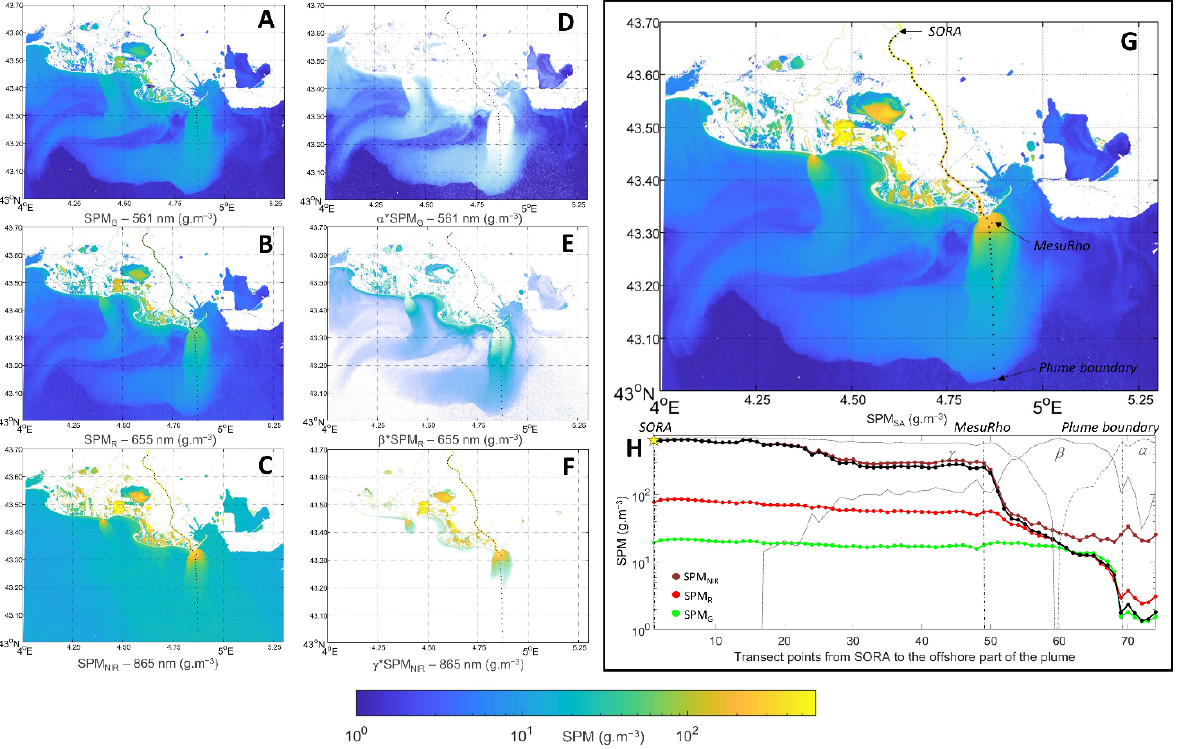
Figure 6. OLI-derived SPM concentration maps of the Rhône River and river plume (6 November 2014). The SPM concentrations were estimated using the Nechad ρ w vs. SPM relationships, recali- brated for the ( A ) green (561 nm), ( B ) red (655 nm), and ( C ) NIR (865 nm) bands, and ( G ) using the switching algorithm (SA). ( D – F ) are the same maps as ( A – C ) but with their opacity weighted by the α , β , and γ factors: white parts represent regions where the weighting factors equal 0 (i.e., the corresponding SPM G , SPM R , or SPM NIR concentration was not used for the computation of the final SPM SA concentration in these areas) while fully opaque parts correspond to a weighting factor